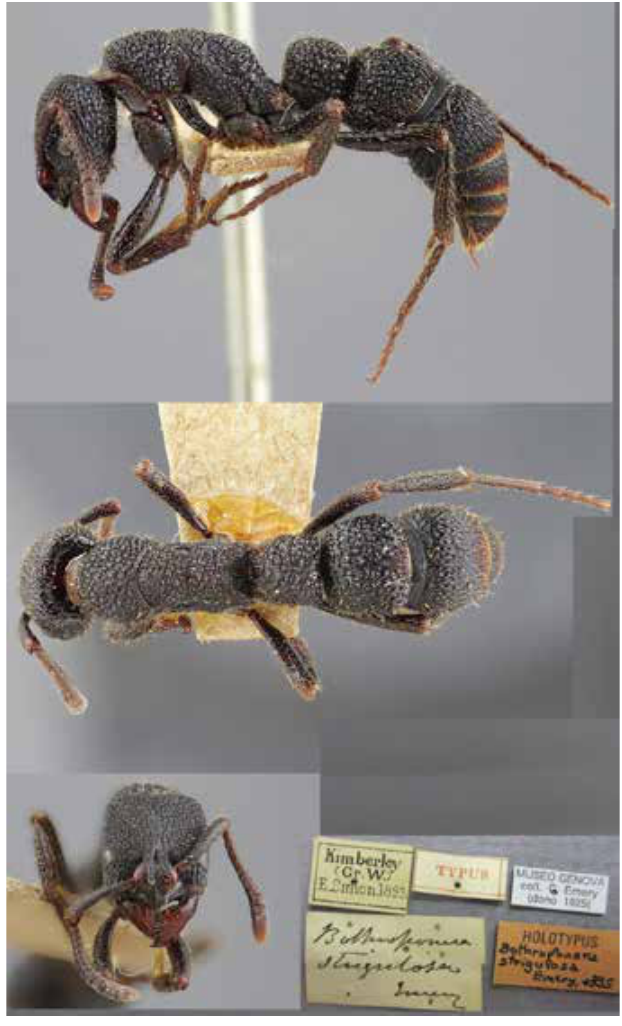
Plate 9 : Bothroponera strigulosa , holotype worker.